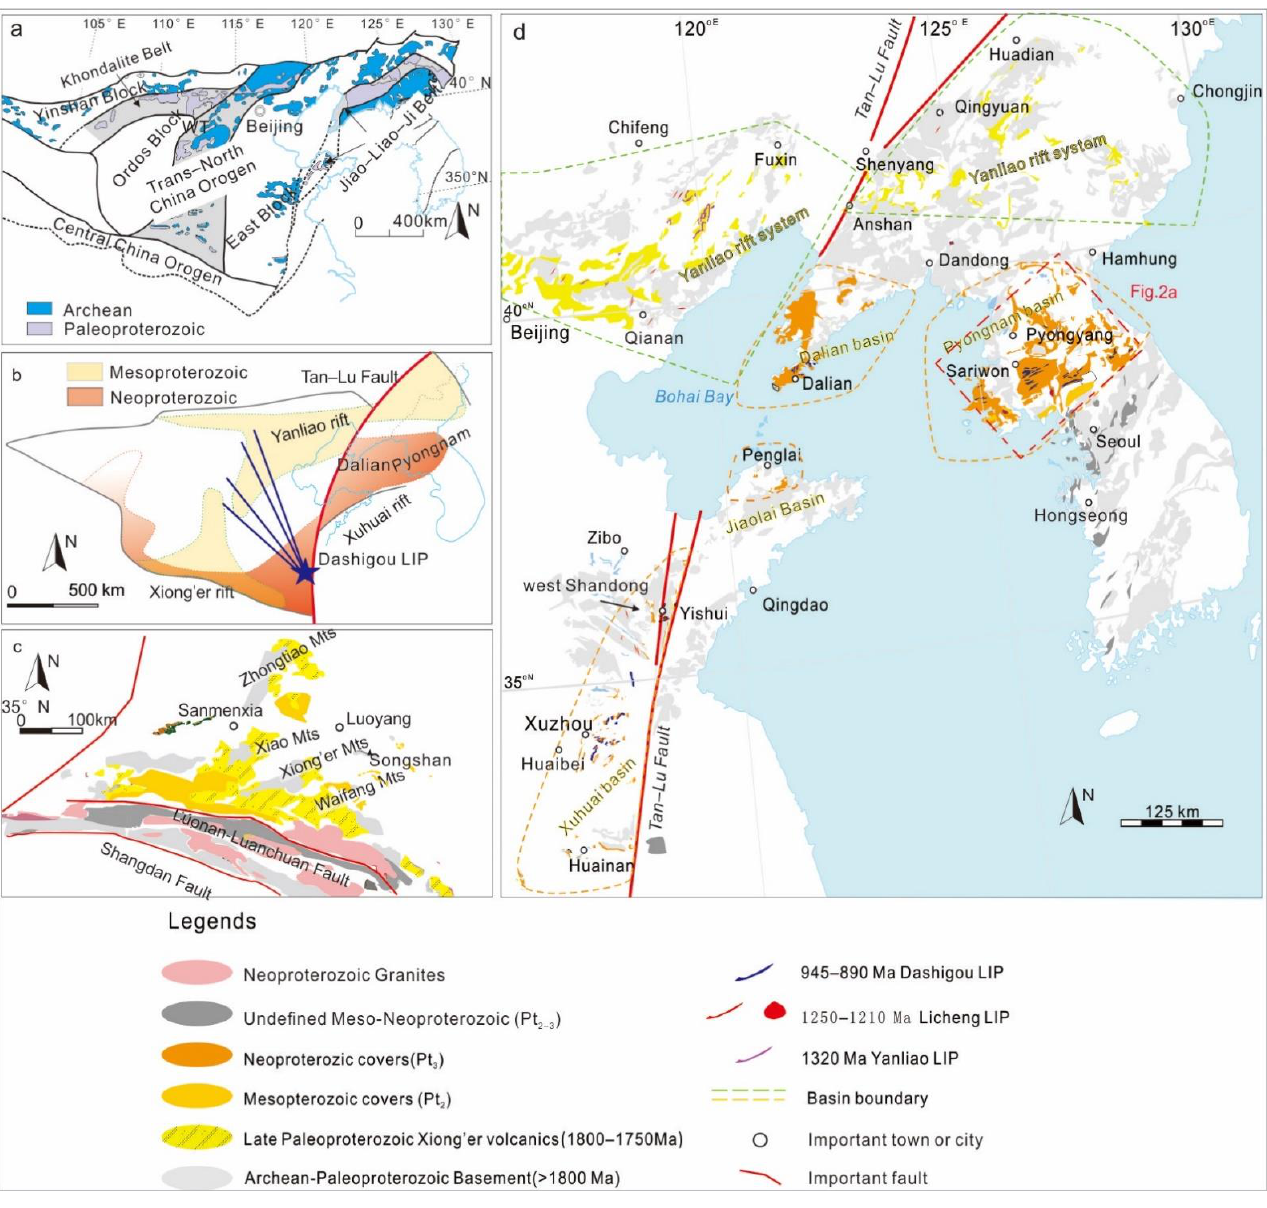
Figure 1. Simplified geological map of the Precambrian Geology of the NCC. ( a ) Paleoproterozoic accretion belts; ( b ) Meso–Neoproterozoic cratonic basins; ( c ) the Songshan area in S NCC; ( d ) the early Neoproterozoic basins in SE NCC.